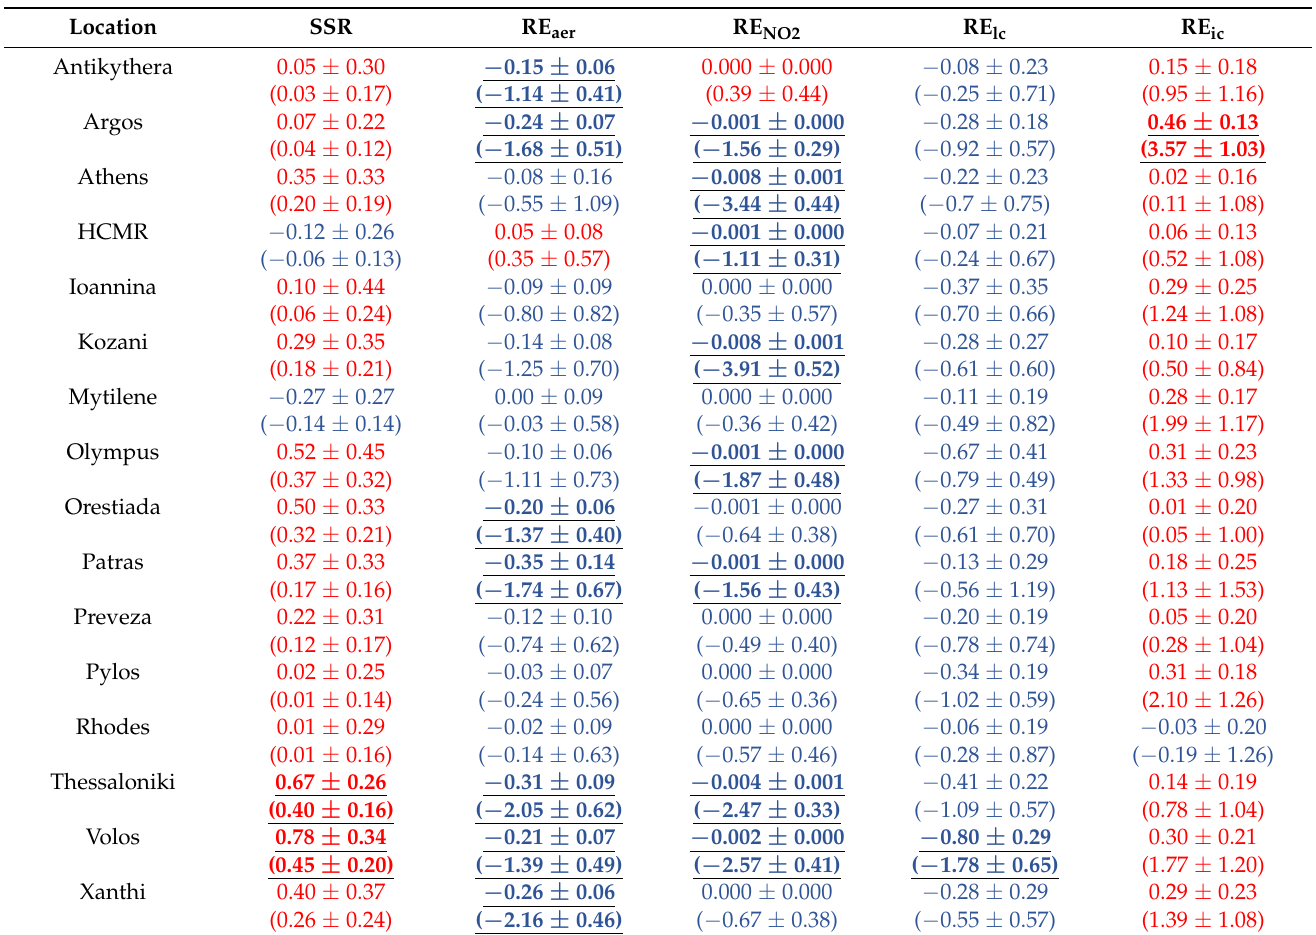
Table 3. Trend (in W/m 2 /year) and relative to the first-year trend (in parentheses; in %/year) of the SSR (data produced in this work based on SBDART) and the radiative effect of aerosols, tropospheric NO 2 , liquid clouds and ice clouds for the period 2005–2019 with the corresponding ± 1 σ . Red/blue color denotes positive/negative trends, respectively. Bold underlined characters are used for statistically significant trends at the 95% confidence